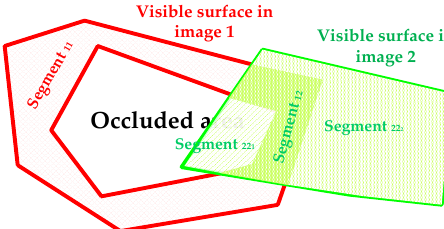
Figure 18. Visible segments of two surfaces in single or multiple images.